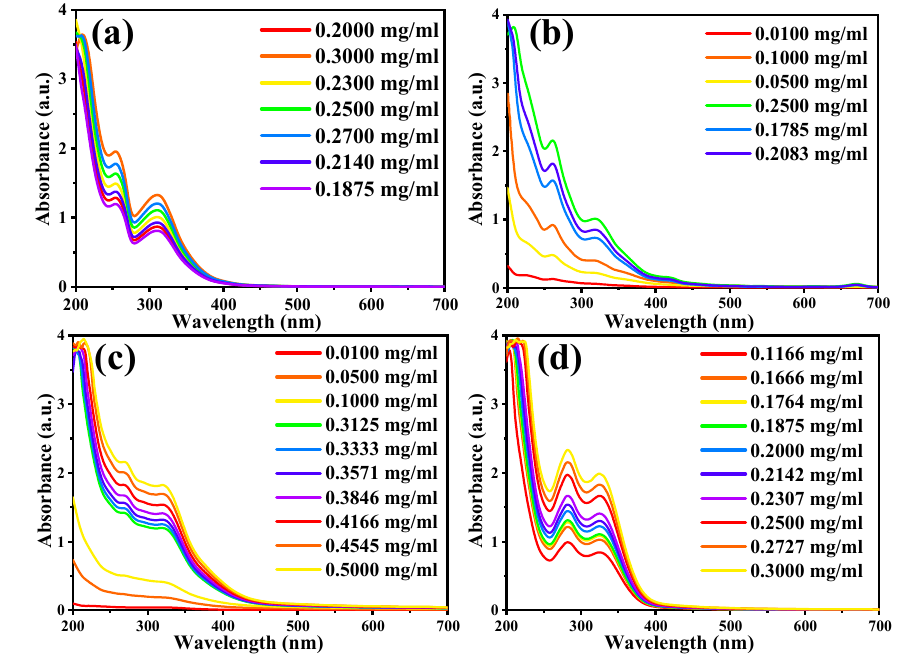
Figure 3. UV-Vis absorbance curve of the plant extracts at different indicated concentrations: ( a ) Daucus carota L. (root), ( b ) Ruta Chalepensis L. (Leaf), ( c ) Anisosciadium DC. (Leaf), and ( d ) Thymus vulgaris L. (Leaf).